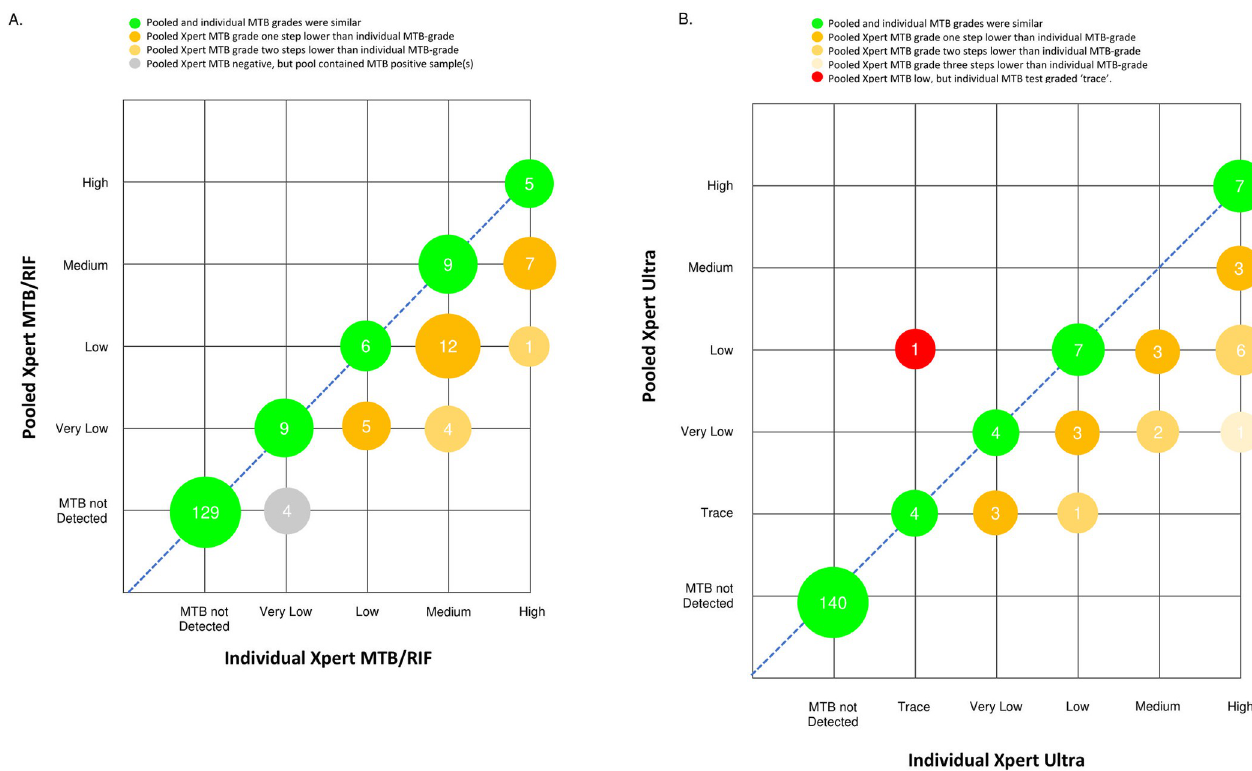
Fig 2. Correlation of individual and pooled (A) Xpert MTB/RIF and (B) Ultra grades (positive pools only include those with one individual Xpert MTB- positive